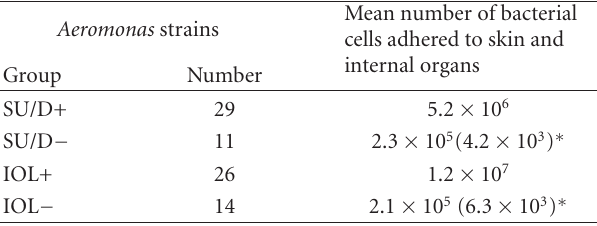
Figure 6: Numerous bacterial cells of A. veronii bt. sobria strain K48 adhering to carp mucus and epidermal cells (a) and carp kidney (b). Table 5: Adhesion intensity of groups of Aeromonas strains which were able (+) or unable ( − ) to cause skin ulcers or dermatitis (SU/D) or any lesions in internal organs (IOL) in both carp and